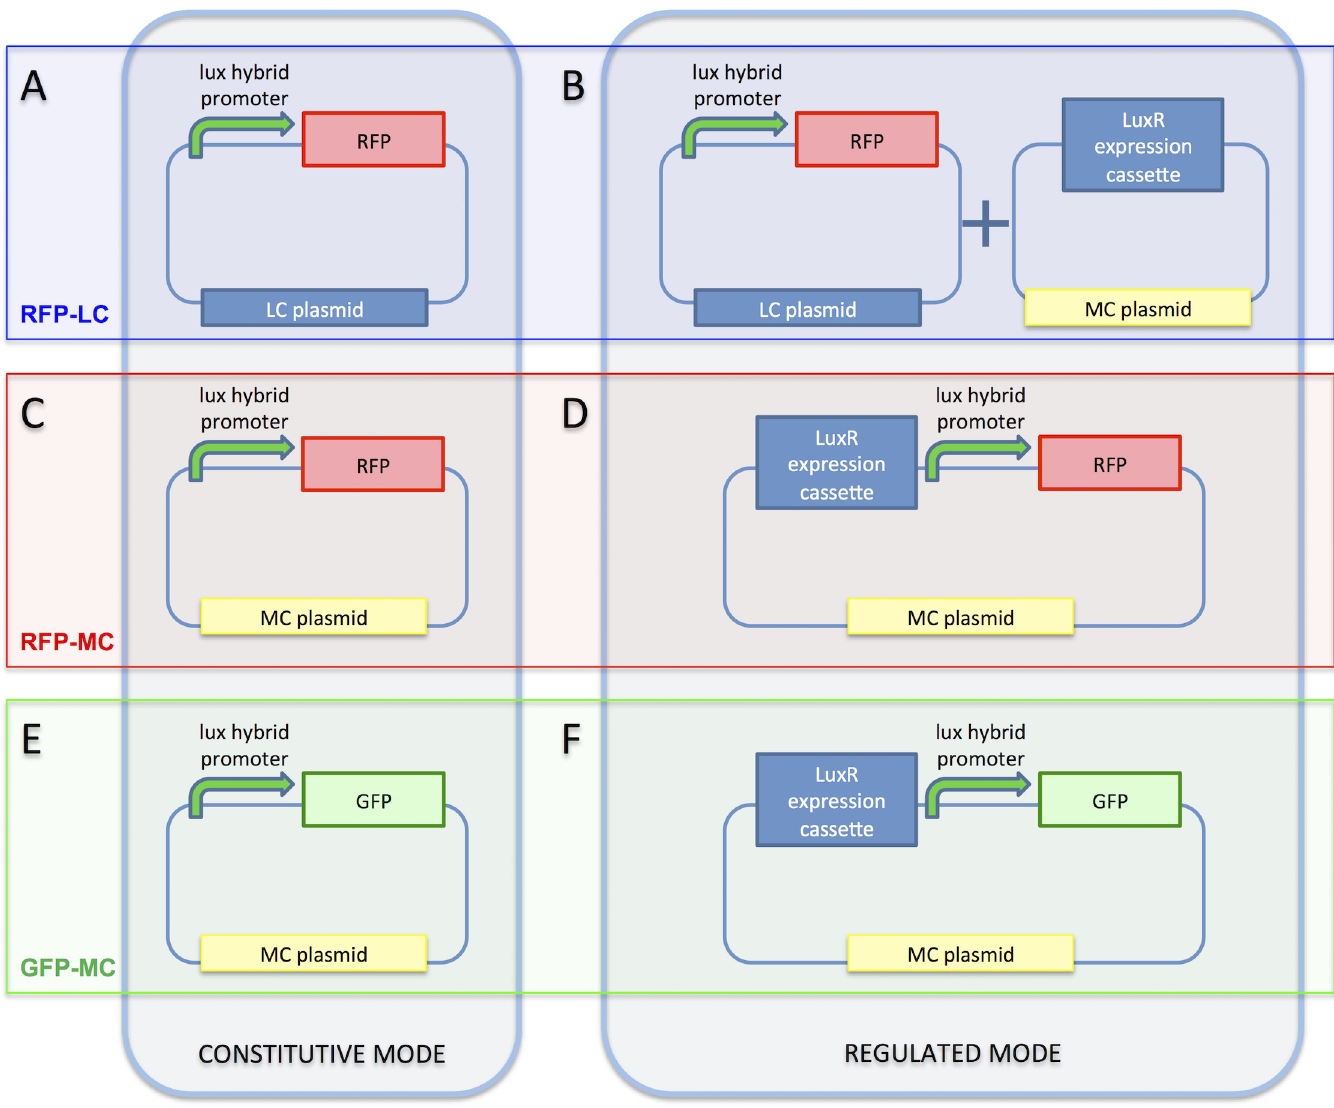
Fig 2. Characterization contexts for the library of LuxR-repressible promoters. The 'constitutive mode' indicates the configuration in which the LuxR expression cassette is absent, while the 'regulated mode' indicates the context in which the LuxR expression cassette is present. A-B panels show the RFP-LC context, in constitutive and regulated mode, respectively; C-D represent the RFP-MC context, in constitutive and regulated mode, respectively; E-F represent the GFP-MC context, in constitutive and regulated mode, respectively. LC and MC plasmids are the pSB4C5 low-copy plasmid and pSB3K3 medium-copy plasmid, respectively. The '+' symbol in panel B indicates that both plasmids are present in the cell.